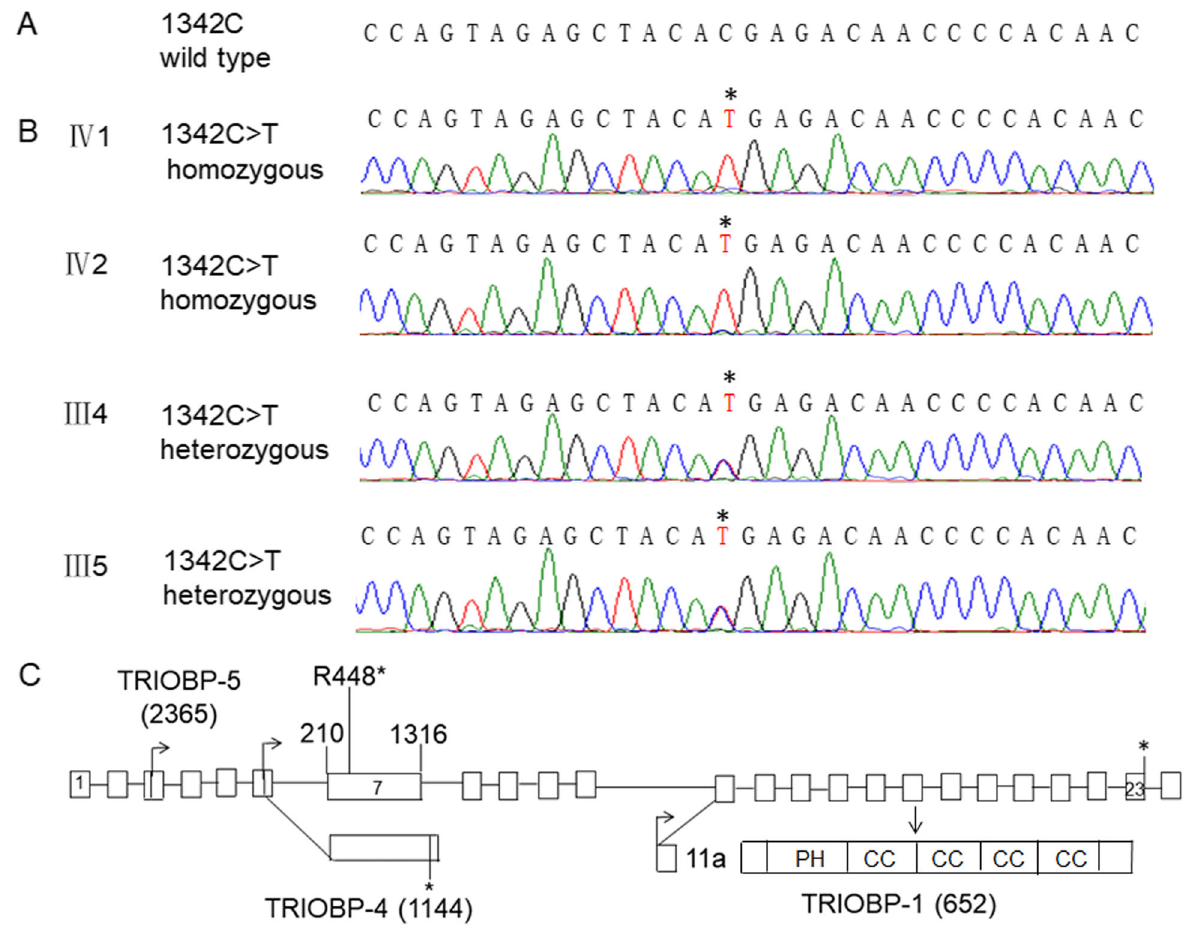
Fig. 2 Identification of the pathogenic TRIOBP variant in the proband ’ s family. a . Sequence of the wild type TRIOBP gene fragment spanning the variant site (1342C). b . Identification of the TRIOBP variant. The proband (IV1) and her younger brother (IV2) carry a homozygous 1342C > T variant, and her mother (III45) and father (III54) carry a heterozygous 1342C> T variant, as indicated by stars. c. Localization of the pathogenic TRIOBP variant. Schematic representations of the genomic structure and alternative transcript classes of TRIOBP: TRIOBP-5 , TRIOBP-4 and TRIOBP-1 [1, 5, 7]. The novel c.1342C > T variant is located in exon 7 of TRIOBP-5 gene and alters the coding codon (Arg448) to a stop codon. Arrows, alternative translation start sites; *alternative stop codon; PH, pleckstrin homology domain; CC, coiled-coil